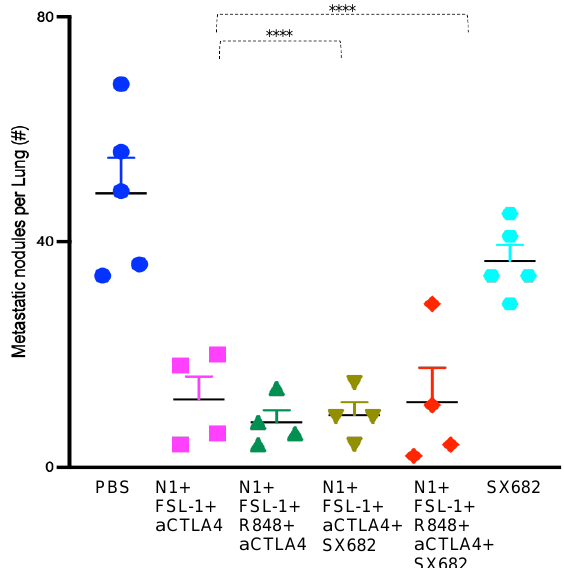
Figure 3. Inhibition of lung metastasis by combined therapeutic regimen. The number of metastatic nodules on the surface of the lung of mice in response to various treatments are shown as mean ± SEM (n = 4~5 mice). **** p < 0.0001.